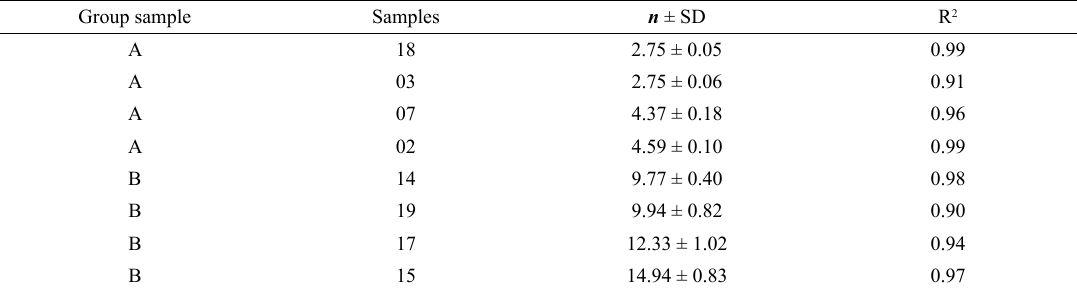
Table 4. Flow behavior indexes for shear-thickening behavior of samples with 20% fumed silica concentration. SD = standard deviation and R 2 = coefficient of determination Group